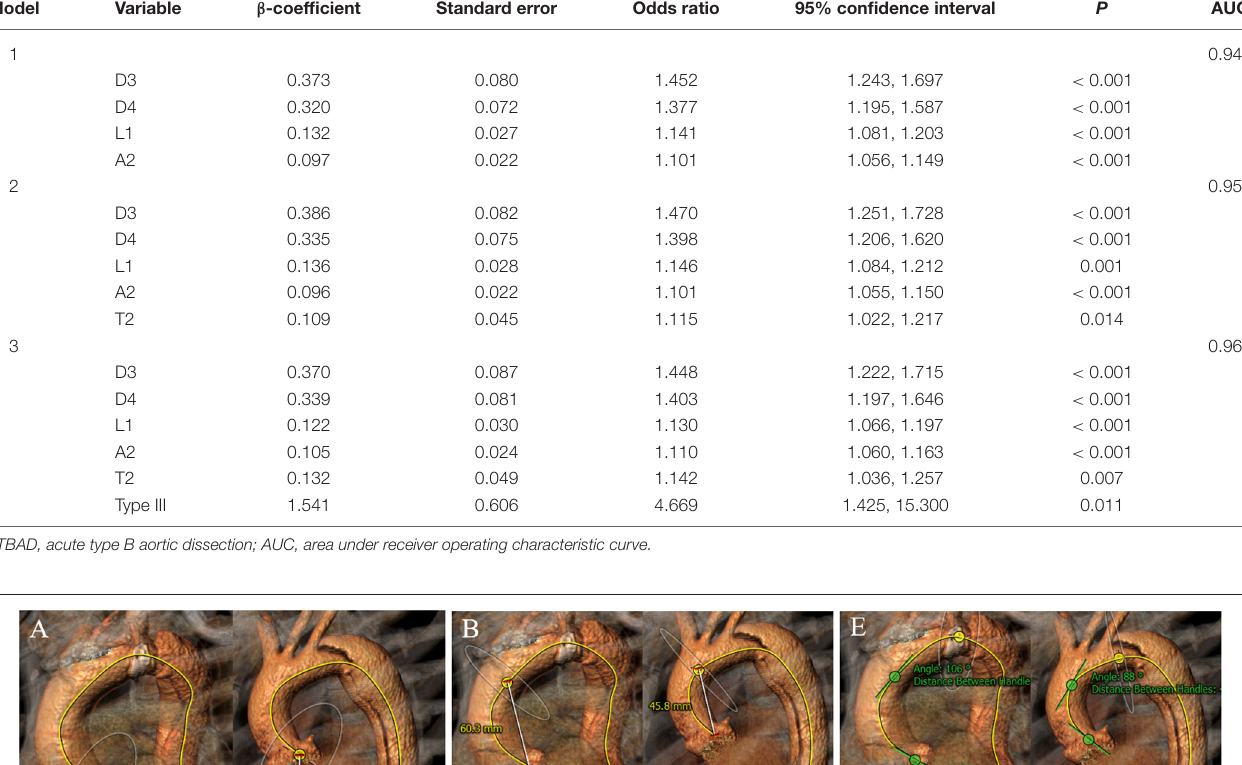
TABLE 4 | Multivariable logistic regression analyses associated with the occurrence of aTBAD. Model Variable β -coefficient Standard error Odds ratio